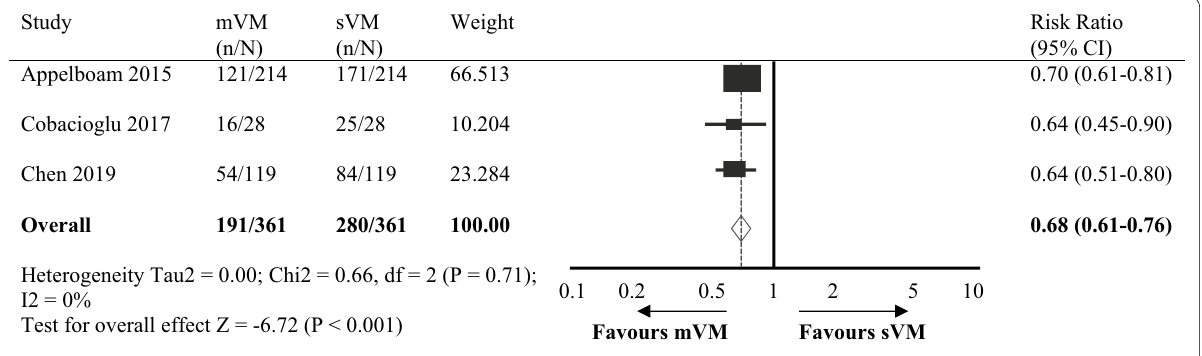
Fig. 3 Comparison of Need for Emergency Treatment between MVM and SVM